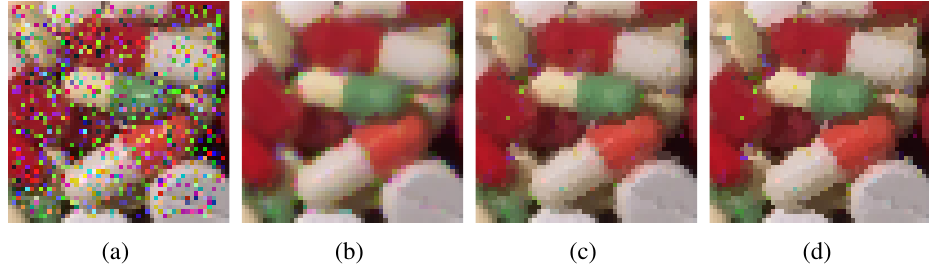
Figure 4. (a) Pills image corrupted with random-value impulse noise with p = 0 : 2 in each colour channel and outputs from: (b) VMMF, (c) VMF and (d) proposed AMMF.